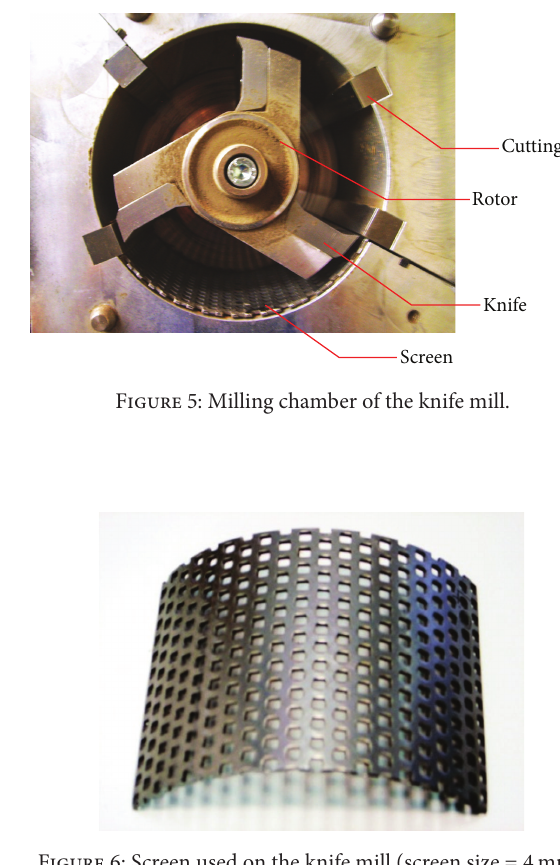
Figure 6: Screen used on the knife mill (screen size = 4